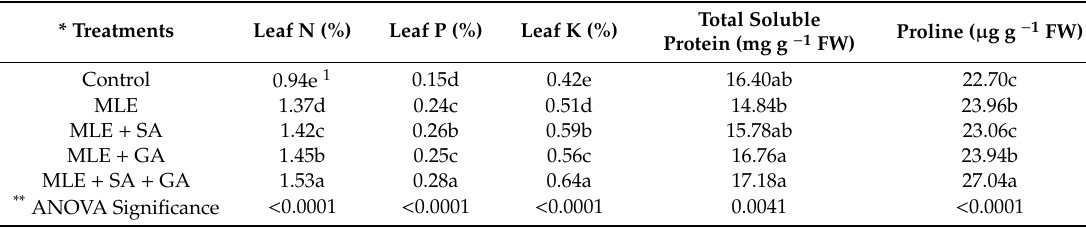
Table 2. E ff ect of soaking corms (24 h) in di ff erent treatment solutions on leaf concentrations of macro nutrients (N, P and K%) and leaf biochemical parameters (total soluble protein and proline) in gladiolus ( Gladiolus grandiflorus cv.